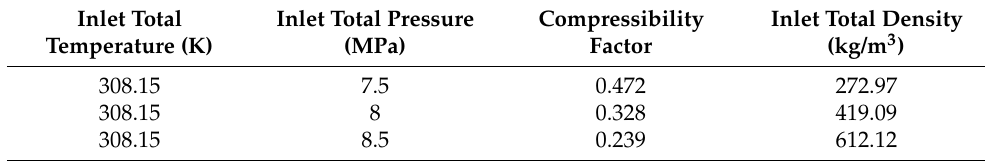
Table 6. Compressibility factors and total densities at various inlet pressures.